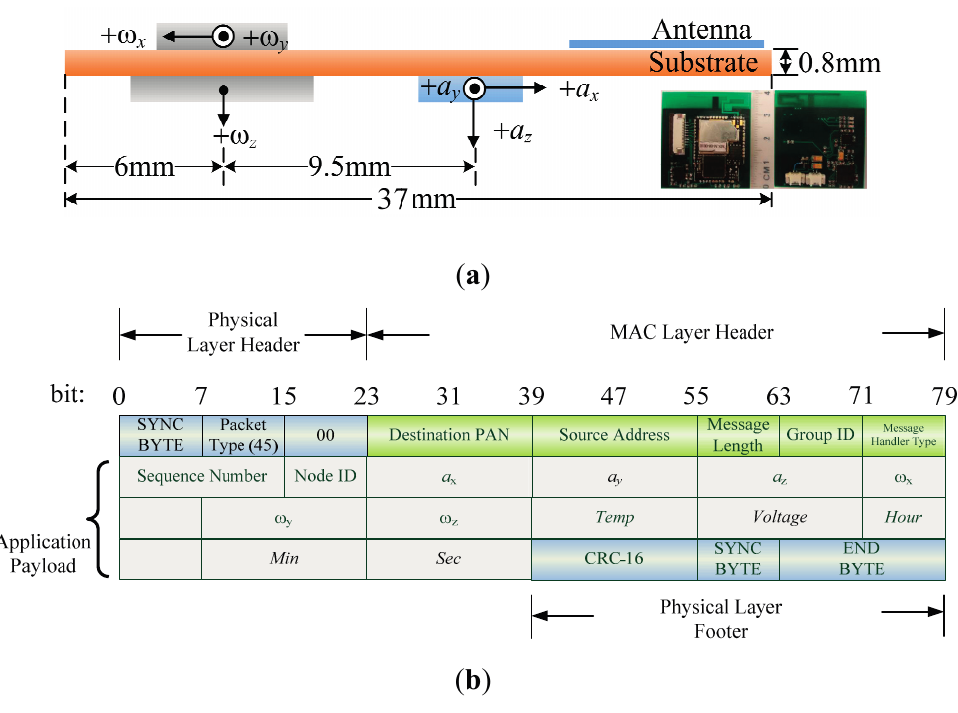
Figure 1. ( a ) Configuration of WSN ISN components and ( b ) payload format of a WSN packet for an